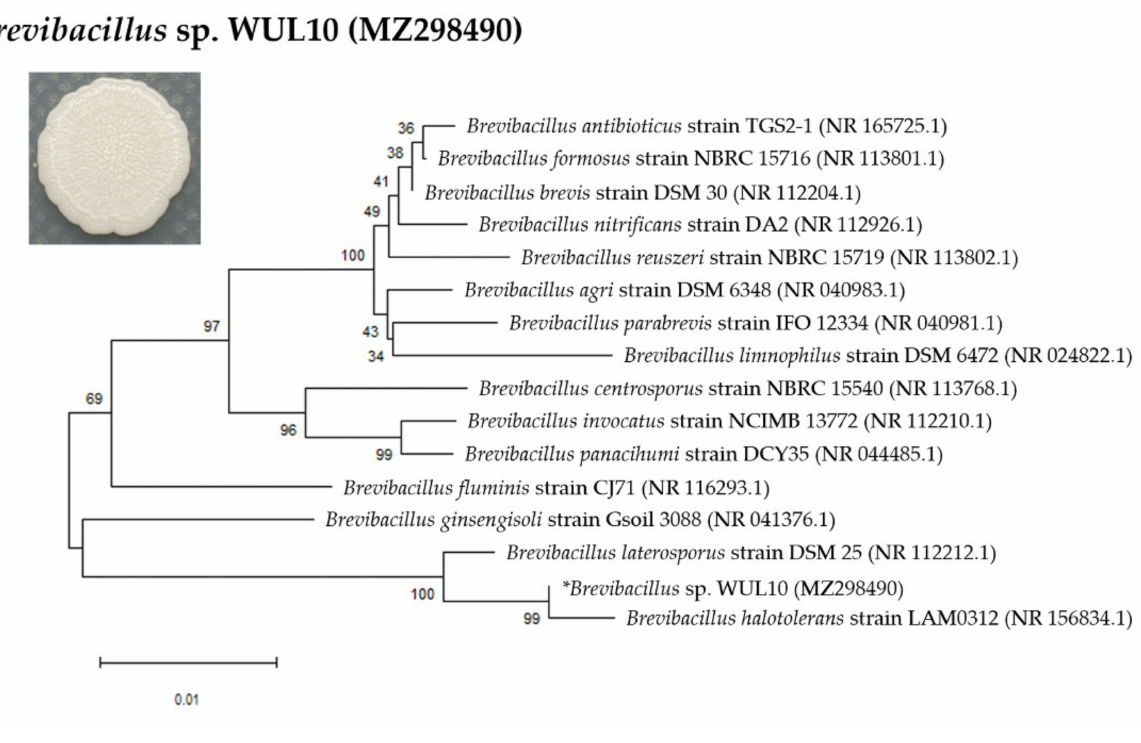
Figure 1. Scanning electron microgram of WUL10 isolate. ( A ) Vegetative cells and ( B ) spores were captured at 10,000 × magnitude.